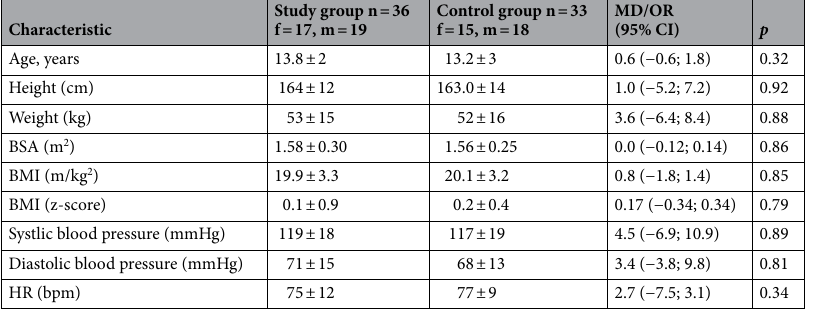
Table 1. Comparison of anthropometrical parameters and vital signs in the study and control groups. BSA body surface area, BMI body mass index, OR odds ratios, MD mean/median differences, f female, m male, bpm beats per